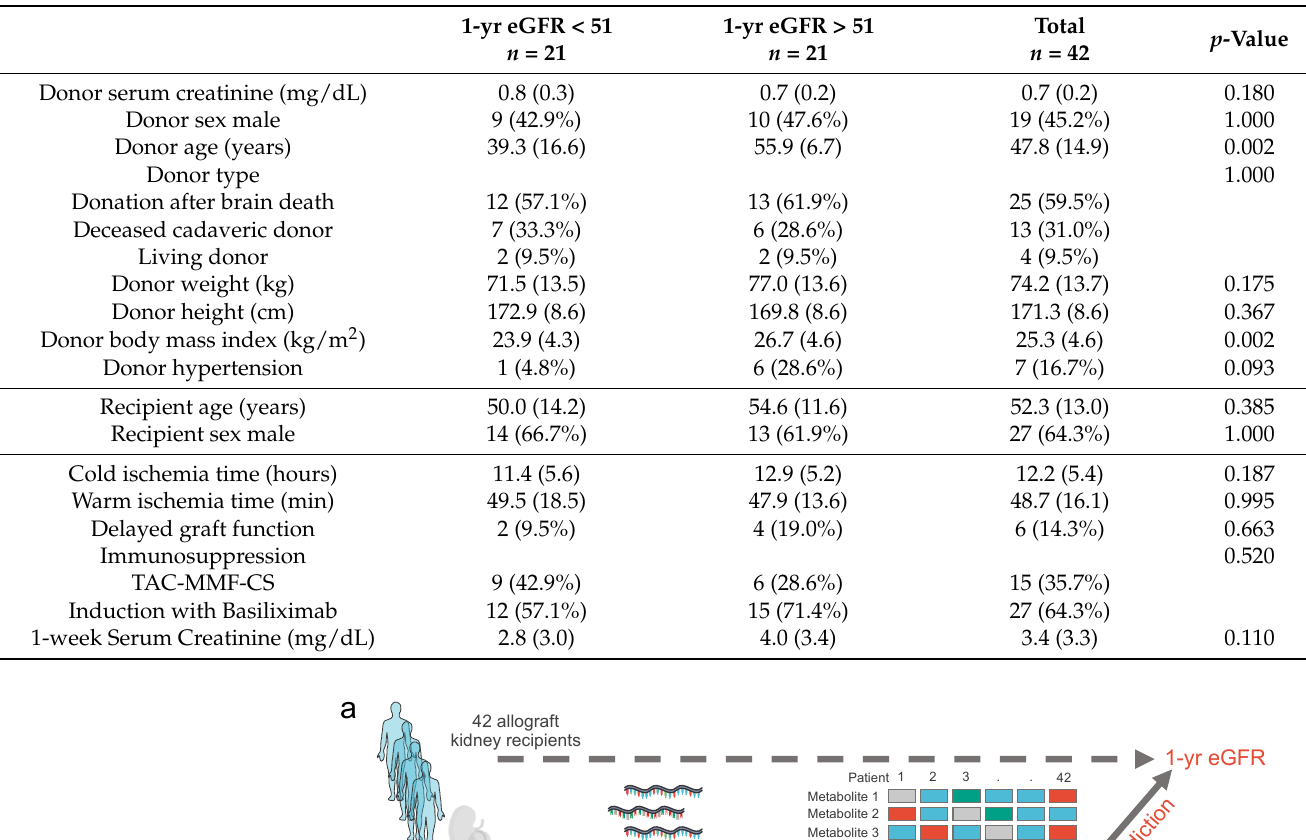
Table 1. Baseline characteristics, according to the median one-year eGFR.